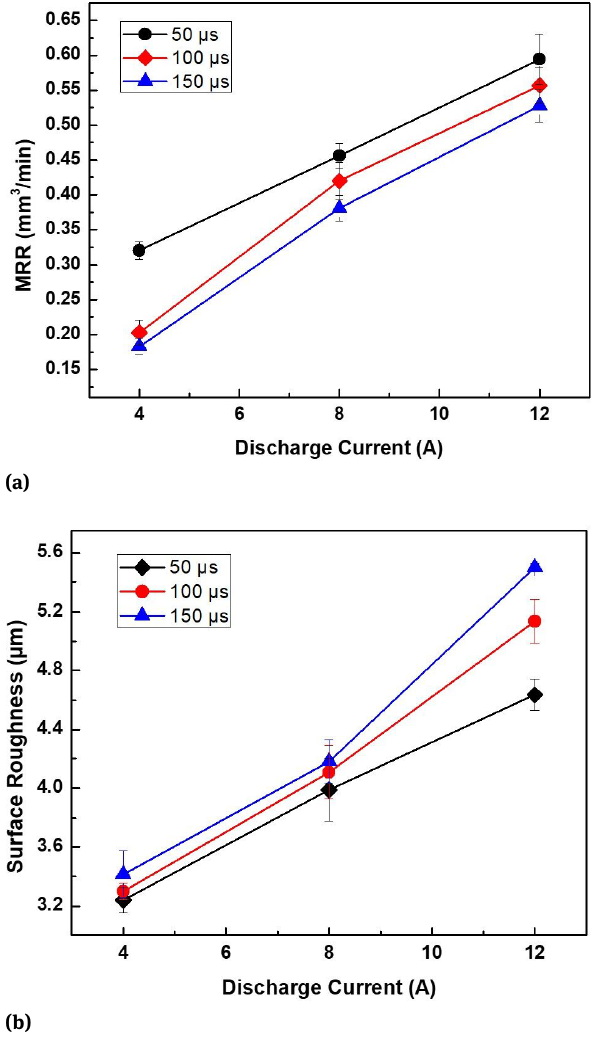
Figure 1: (a) MRR curves of BMG machined surface varied by dis- charge current and pulse-on time and (b) surface roughness curves of BMG machined surface varied by discharge current and pulse-on time of BMG sinking